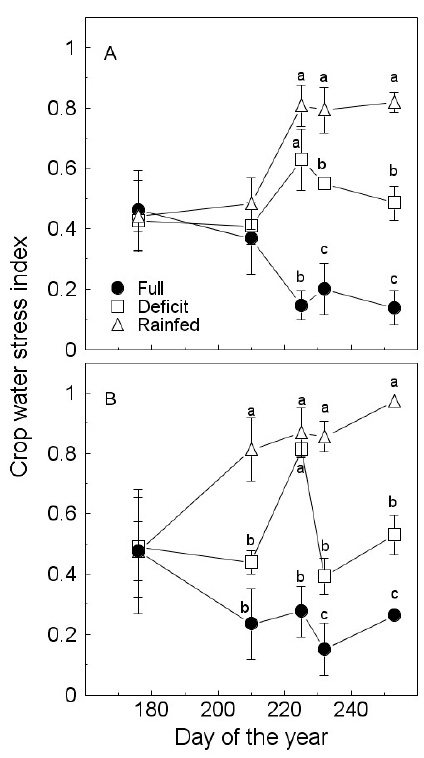
Figure 4. Seasonal course of crop water stress index (CWSI), calculated by UAV thermal imagery, of olive trees of cv. Frantoio ( A ) and Leccino ( B ) subjected to full irrigation, deficit irrigation, or rainfed conditions in 2020. Symbols are means ± standard error of 4 trees. Different letters indicate differences between irrigation treatments after ANOVA ( p < 0.05) within each date of measurement. There was a tight, linear correlation between the canopy volume calculated by UAV imagery and LAI of olive trees of both cultivars (Figure